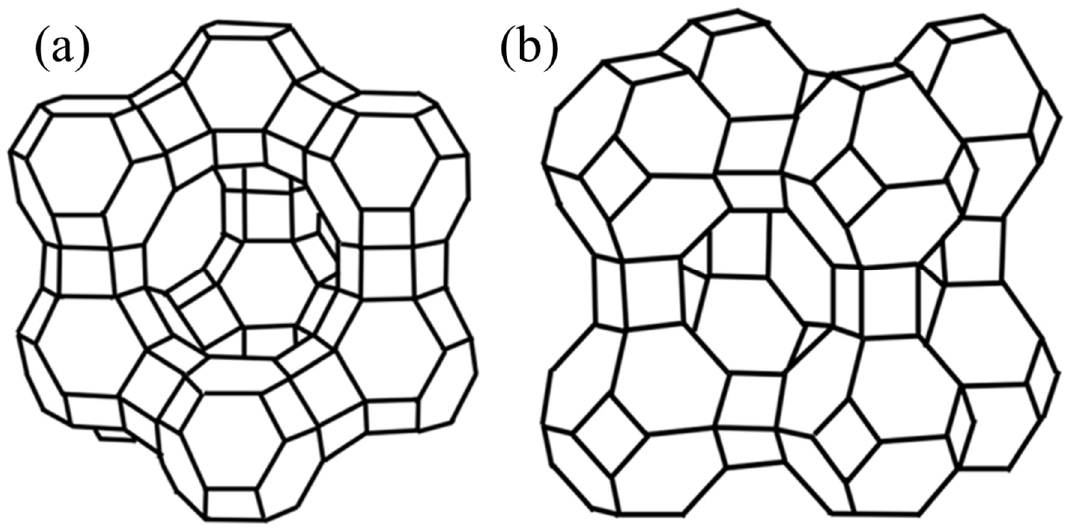
Figure 1. One of the most common zeolite frameworks: ( a ) Faujasite; ( b ) Zeolite type A.